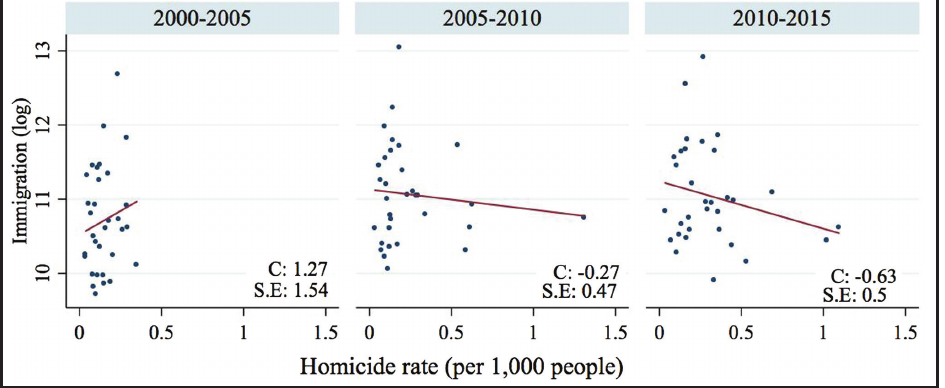
Note : C stands for slope coefficient and S.E. for standard error of fitting